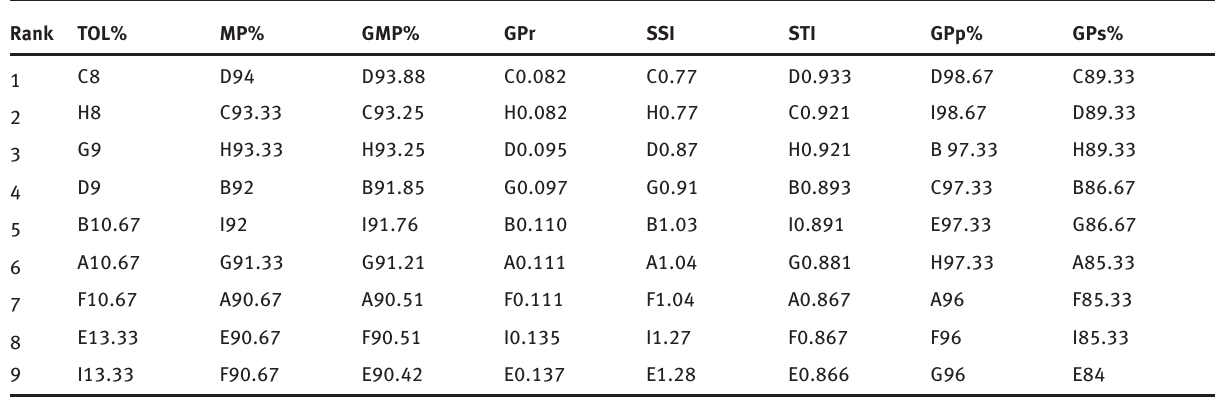
Table 4: Stress tolerance indices values for studied genotypes (S1 vs. S5)